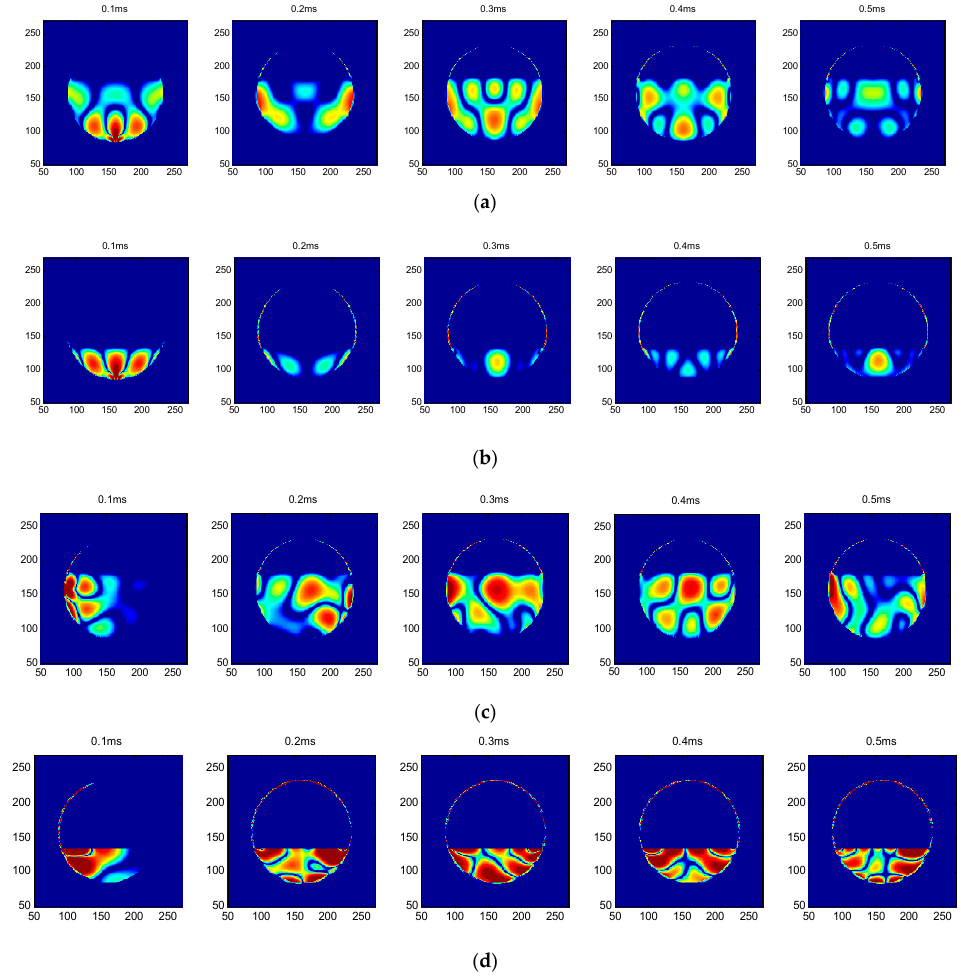
Figure 4. Snapshots of the 1/3 and 2/3 concrete infill conditions excited by R3 or R4: ( a ) the 2/3 concrete infill condition, excited by R3; ( b ) the 1/3 concrete infill condition, excited by R3; ( c ) the 2/3 concrete infill condition, excited by R4; ( d ) the 1/3 concrete infill condition, excited by R4.